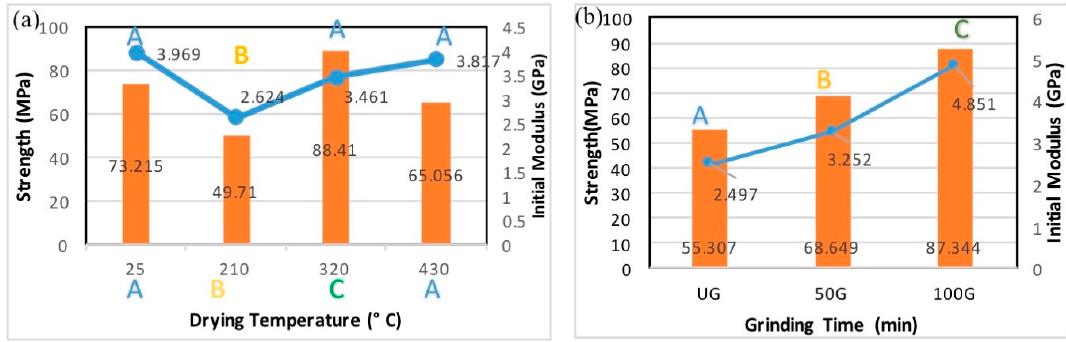
Figure 8. ( a ) Influence of drying temperature on initial modulus and strength of filaments classified according to drying temperature (each bar represents average value for filaments produced from different CNF types dried at the temperature listed); ( b ) Influence of CNF grinding time on initial modulus and strength of filaments.